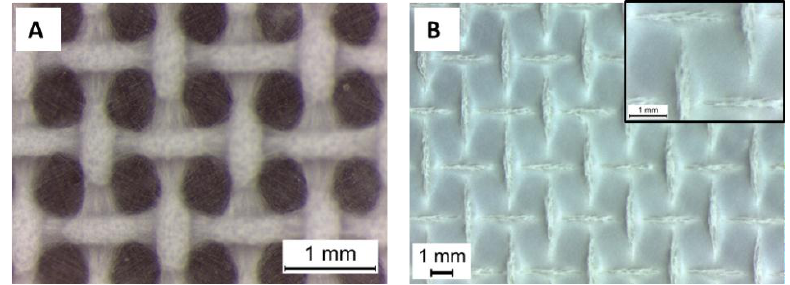
Figure 6. Light Microscope image of PCL nanofibers pattern: with the narrow pattern (magnification 4×) ( A ); and with the wide pattern (magnification 1× and in the inlet 4×, scale bar 1 mm) ( B ).